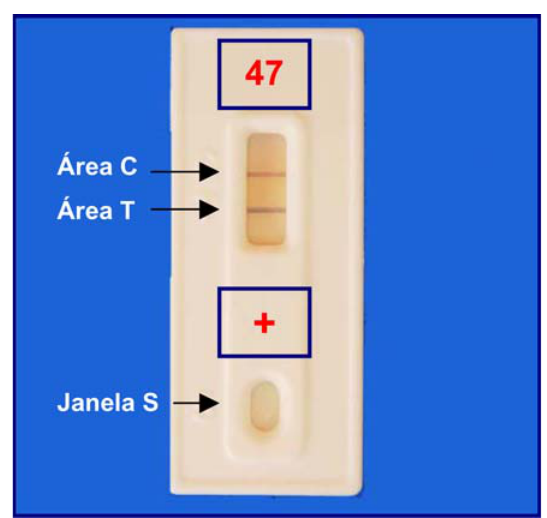
FIGURA 2 - Dispositivo imunocromatográfico com reação positiva para H. pylori no cão 47. A positividade é observada pela faixa rósea na área T (teste) do dispositivo.